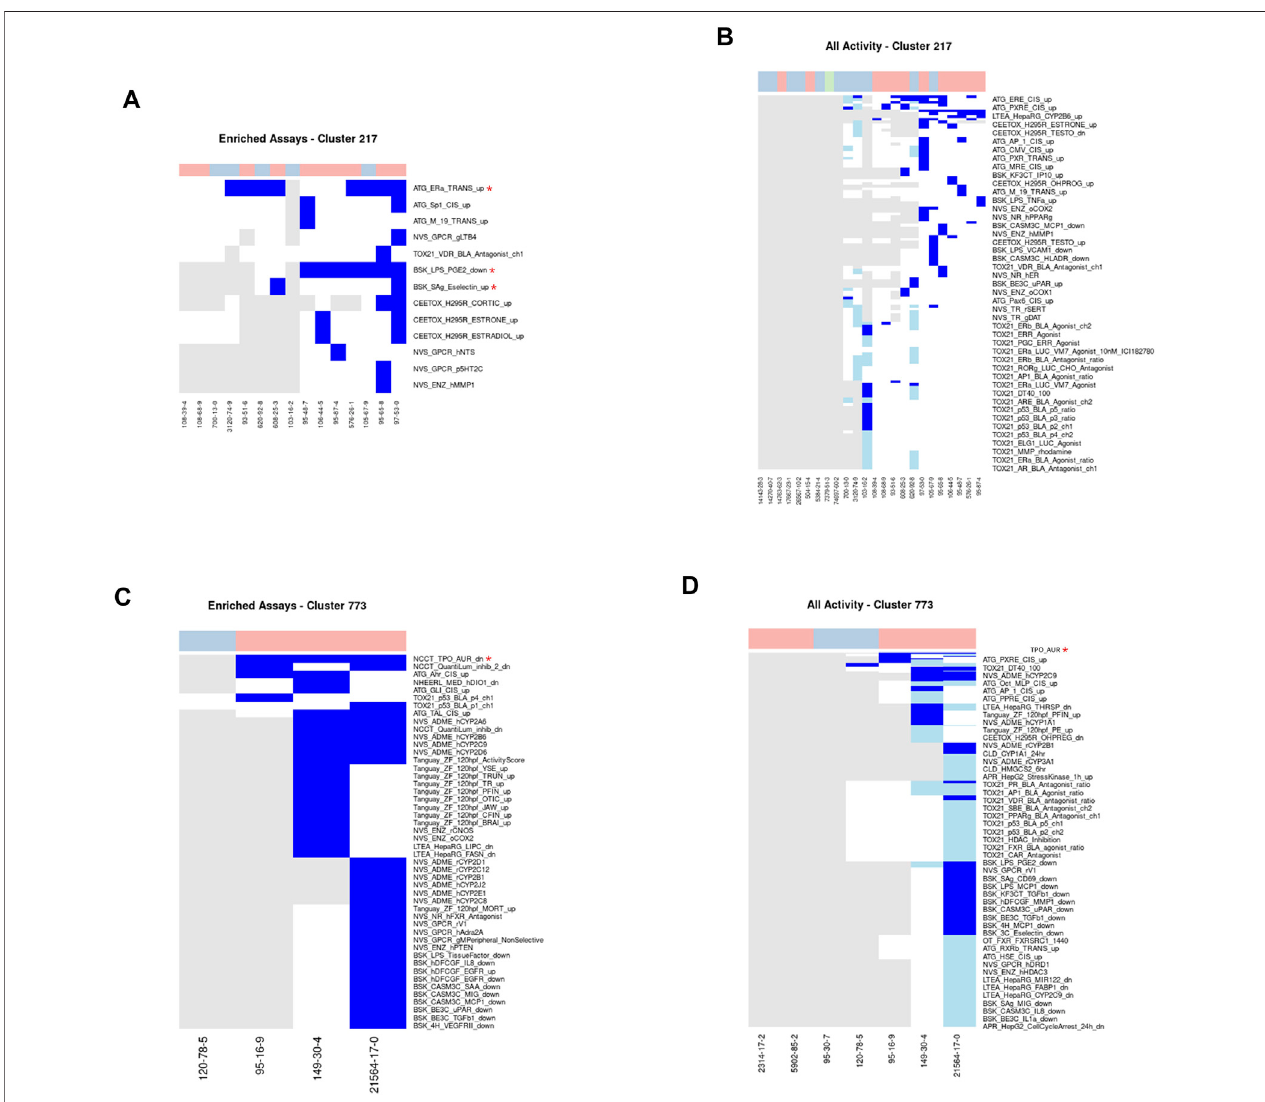
FIGURE 6 | Clusters 217 and 773.A/C. Heatmap showing activity below the cytotoxicity range in the assays that were enriched for clusters 217 (A) and 773 (C) . Onlychemicalswithactivityinatleastoneassayareshown.B/D.Heatmapshowingactivityforallassayswhereatleastonechemicalfromtheclusters217 (B) or773 (D) wasactive.Heatmapcolors:blue=activebelowthecytotoxicitypoint,lightblue=activeabovethecytotoxicitypoint,white=inactive,grey=nottested.Topofheatmap: red = toxic, blue = nontoxic, aquamarine = unde fi ned. Red asterisks identify the assay(s) selected for that cluster.